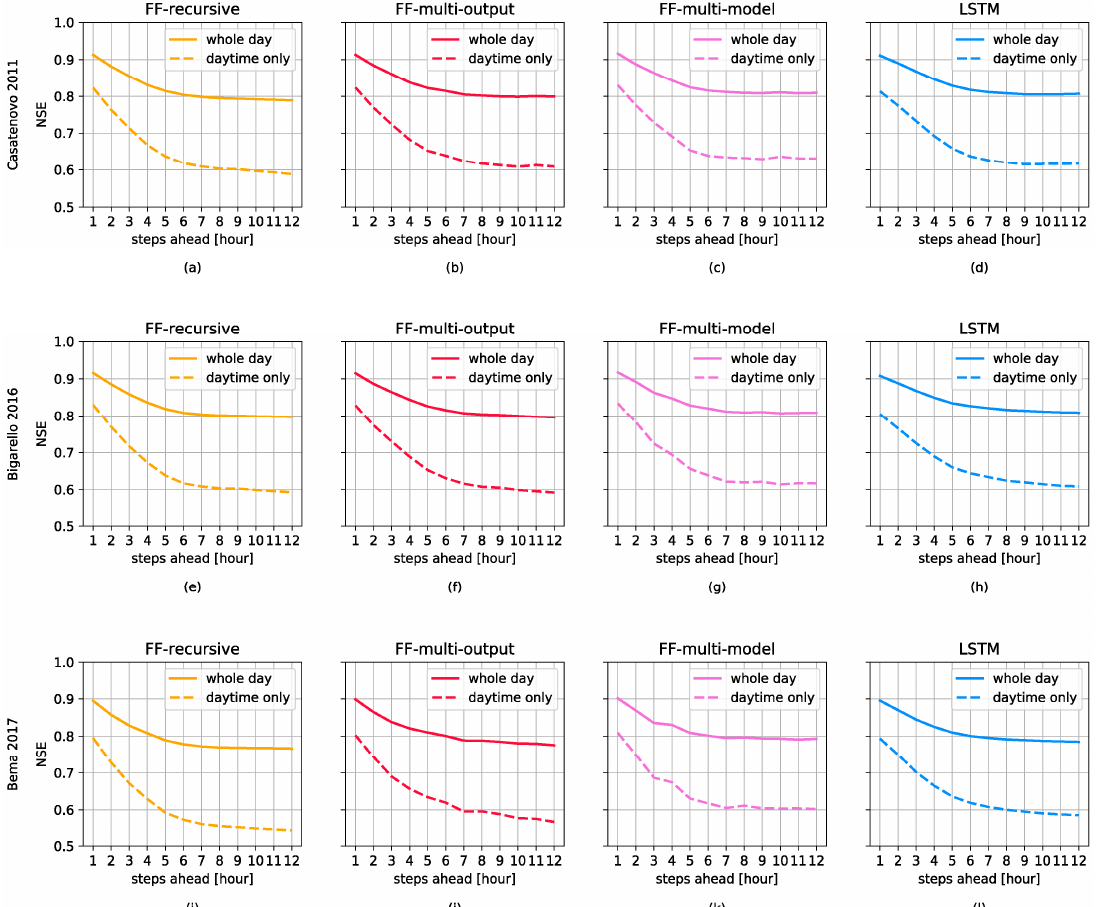
Figure 6. NSE of hourly solar irradiance forecast at Casatenovo ( a – d ) in 2011, Bigarello ( e – h ) in 2016, and Bema ( i – l ) in 2017. Each column is relative to a different neural predictor. Solid line represents the performance in the whole day, dashed line in daytime only.